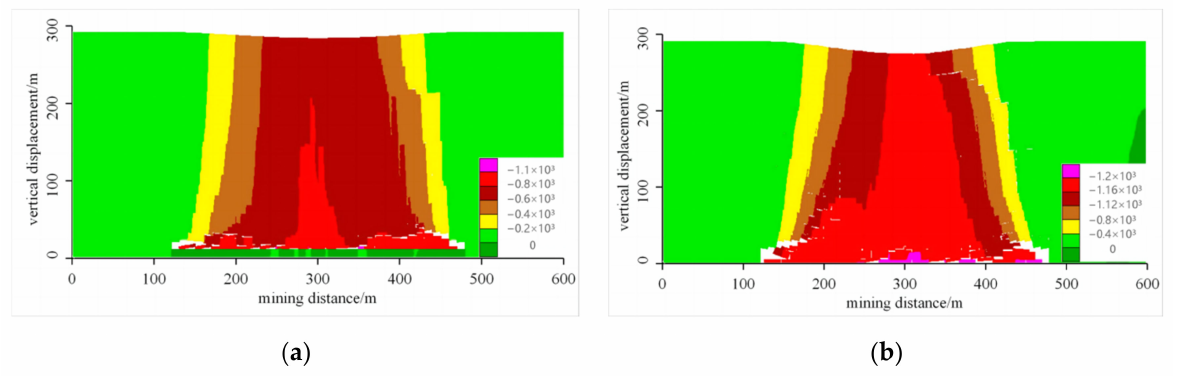
Figure 11. Vertical displacement under overburden under mining at the end of the first ( a ) and second ( b ) slice